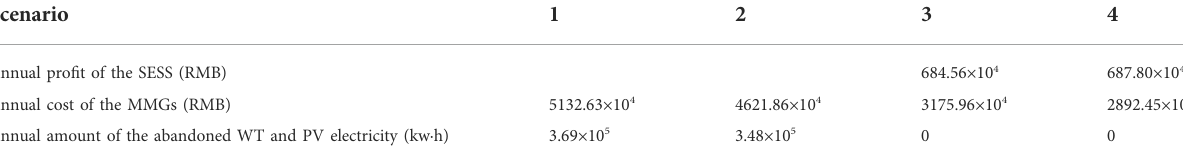
TABLE 2 Comparison of the annual pro fi t of the SESS, annual cost of the MMGs, and annual amount of the abandoned WT and PV electricity. Scenario